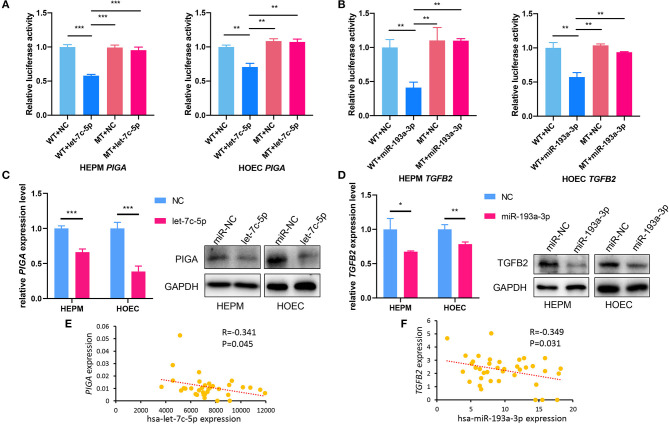
PIGA and TGFB2 are target genes of let-7c-5p and miR-193a-3p, respectively. (A) Dual-luciferase reporter assays showed that overexpression of let-7c-5p (A) and miR-193a-3p (B) can decrease the luciferase activity of the WT 3′-UTR of PIGA and TGFB2, respectively, but did not influence the MT of 3′-UTR. (C) qPCR and Western Blot showed that overexpression of let-7c-5p (C) and miR-193a-3p (D) significantly reduced mRNA and protein expression of PIGA and TGFB2. (E,F) The inverse correlation between has-let-7c-5p-PIGA
(E) and has-miR-193a-3p-TGFB2
(F) was detected in NSCL/P lip tissue samples. WT, Wild-type; MT, Mutation-type; NC, Negative control; UTR, untranslated region, NSCL/P, non-syndromic cleft lip with or without cleft palate. *P < 0.05, **P < 0.01, ***P < 0.001.